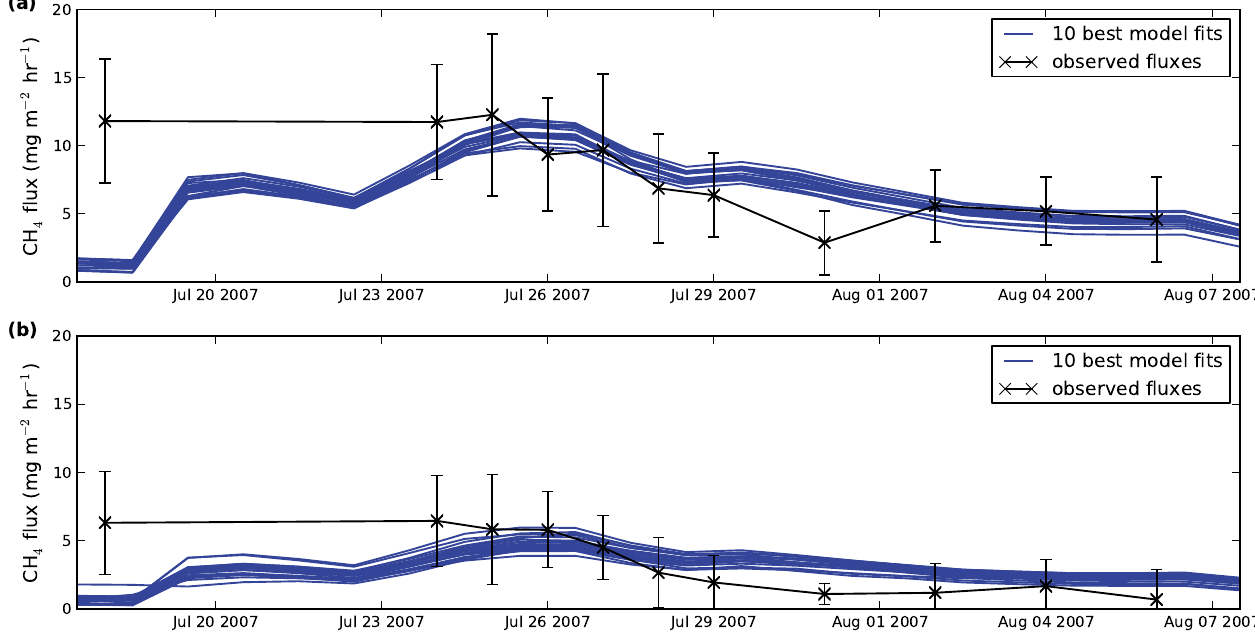
Fig. 4. The 10 best model fits (grey) plotted together with observed data (black). Error bars denote standard deviations. Table 2. Mean methane oxidation rates for the two ana- lyzed Sphagnum samples from sites NS1 and NS2 at different incubation temperatures. The values are in µmol CH 4 g − 1 dry weight/day ± standard deviation ( n =